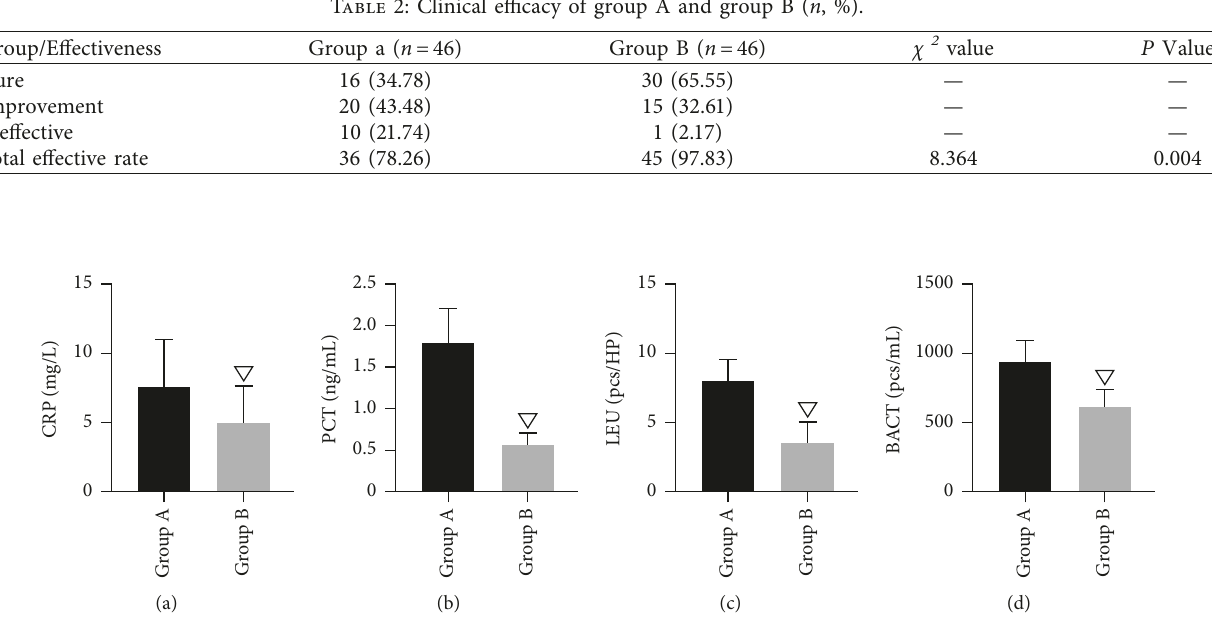
Figure 2: Comparison of serum and urine indexes between group A and group B after treatment. Contents in (a–d) are CRP, PCT, LEU, and BACT, respectively. ▽ P < 0 . 05 compared with group